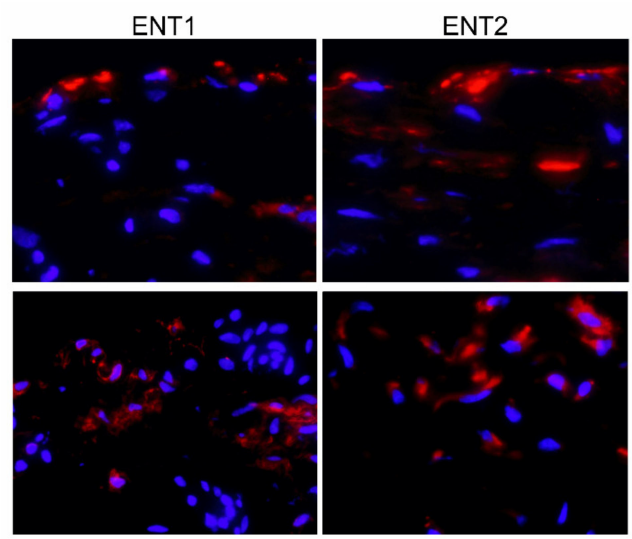
Figure 2. ENT1/2 expression in the synovium. Representative fluorescent micrographs of OA and RA synovial tissues immunostained for ENT1 and ENT2 (red) and counterstained for nuclei with DAPI (blue) (bar: 50 µ m). Abbreviations: DAPI—4 (cid:48) ,6-diamidino-2-phenylindole; ENT—equilibrative